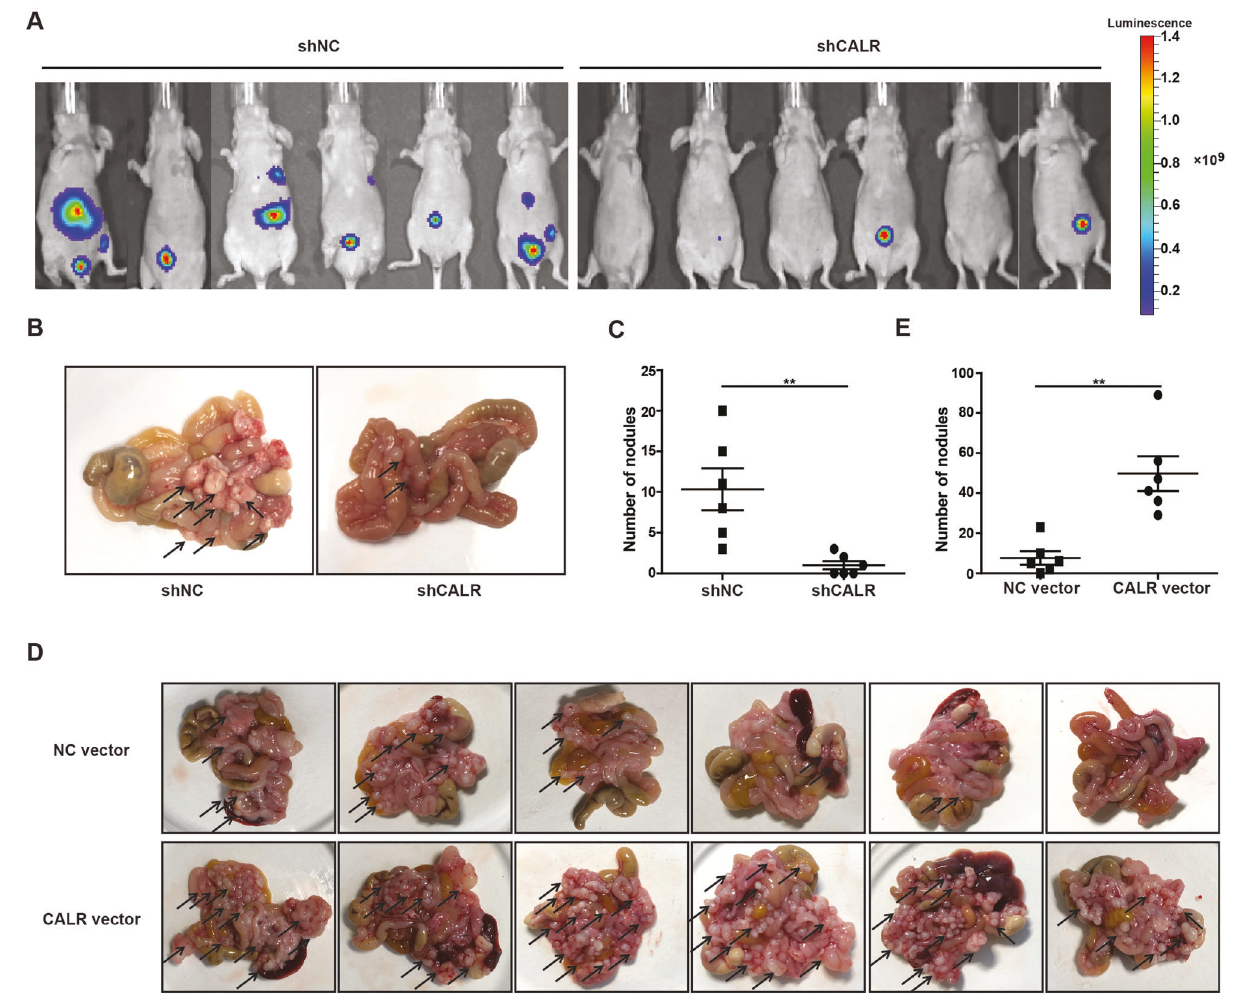
Fig. 3 CALR regulated GC cells metastasis in vivo. Representative images of the GC abdominal spread model after respectively intraperitoneal injection with GC cells stably knocking down CALR/NC vector ( A and B , n = 6 vs 6) and stably overexpressing CALR/NC vector ( D , n = 6 vs 6). C , E Evaluation of the number of tumor nodules in mice abdominal cavities. Data are presented as mean ± SEM. * P < 0.05, ** P < 0.01, *** P <